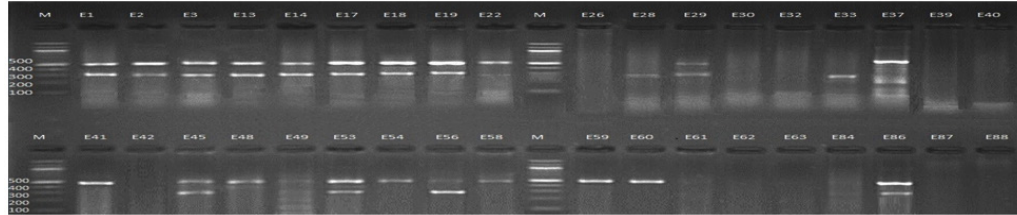
Fig. 1. 1.5% Agarose gel electrophoresis at 72 volt for 90 minutes of PCR to blaCTX-M-I amplicon (499bp) and blaCTX-M-III amplicon (305bp); lane M represent DNA marker size(100bp) while E1-E88 represent the isolates